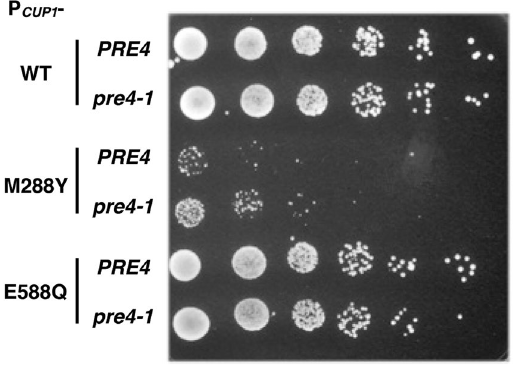
Figure 4. A protease-deficient mutant of the 20S proteasome partially suppressed the M288 Φ lethal phenotype. PRE4 and pre4-1 cells were transformed with the CUP1 promoter-regulated plasmid expressing wild-type Cdc48 (WT) and mutant Cdc48 with the replacement of E588Q and M288Y. The transformants were grown on media supplemented with 20 µ M CuCl 2 at 30 °C for 2